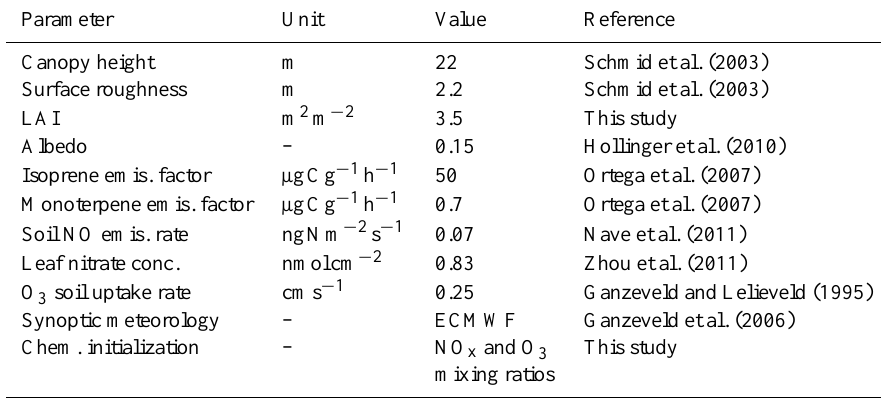
Table 1. Model input parameters for the UMBS AmeriFlux site. Parameter Unit Value Canopy height